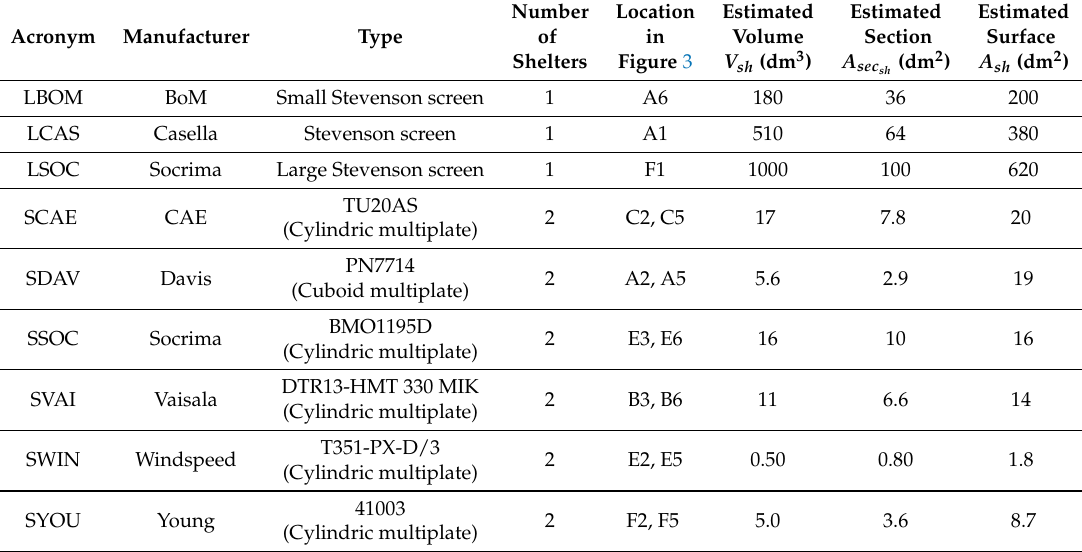
Figure 3. Disposition of the instruments within the measurement site area. Source: Lacombe et al. [10]. Table 2. Main characteristics of the naturally ventilated shelters used during the WMO